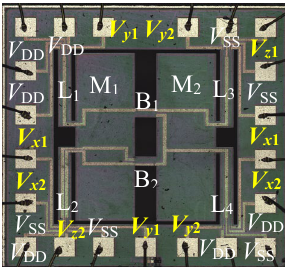
Figure 6. The photograph of the proposed three-axis acceleration sensor chip.